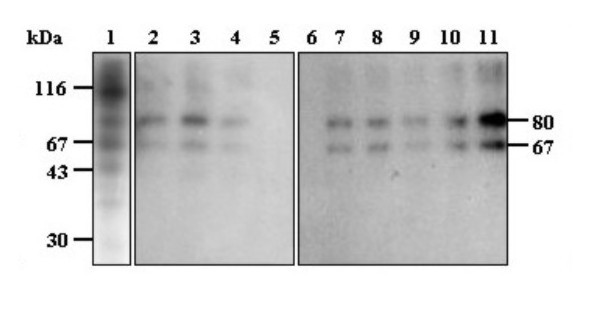
Immunoprecipitation of labeled membrane proteins. Proteins from C6/36 cell apical surfaces radiolabeled with 125I (lane 1) were immunoprecipitated with polyclonal anti-MG (lane 2) or anti-membrane (lane 3 and 4) and separated by 10% SDS-PAGE. The molecular weights of the immunoprecipitated proteins are shown on the left side. A negative control using an unrelated antibody (anti-actin) is shown in lane 5. Labeled apical cell surface proteins recognized by DEN1 (lane 7), DEN2 (lane 8), DEN3 (lane 9) and DEN4 (lane 10) were immunoprecipitated with specific anti-DENV as described in the methods section. A control without DEN virus was included (lane 6). 125I-labeled proteins immunoprecipitated by anti-EP were used as a positive control (lane 11). All proteins were separated by 10% SDS-PAGE and labeled proteins were detected by autoradiography. The molecular weights of these proteins are shown on the right side. Molecular weight markers are shown on the left side.